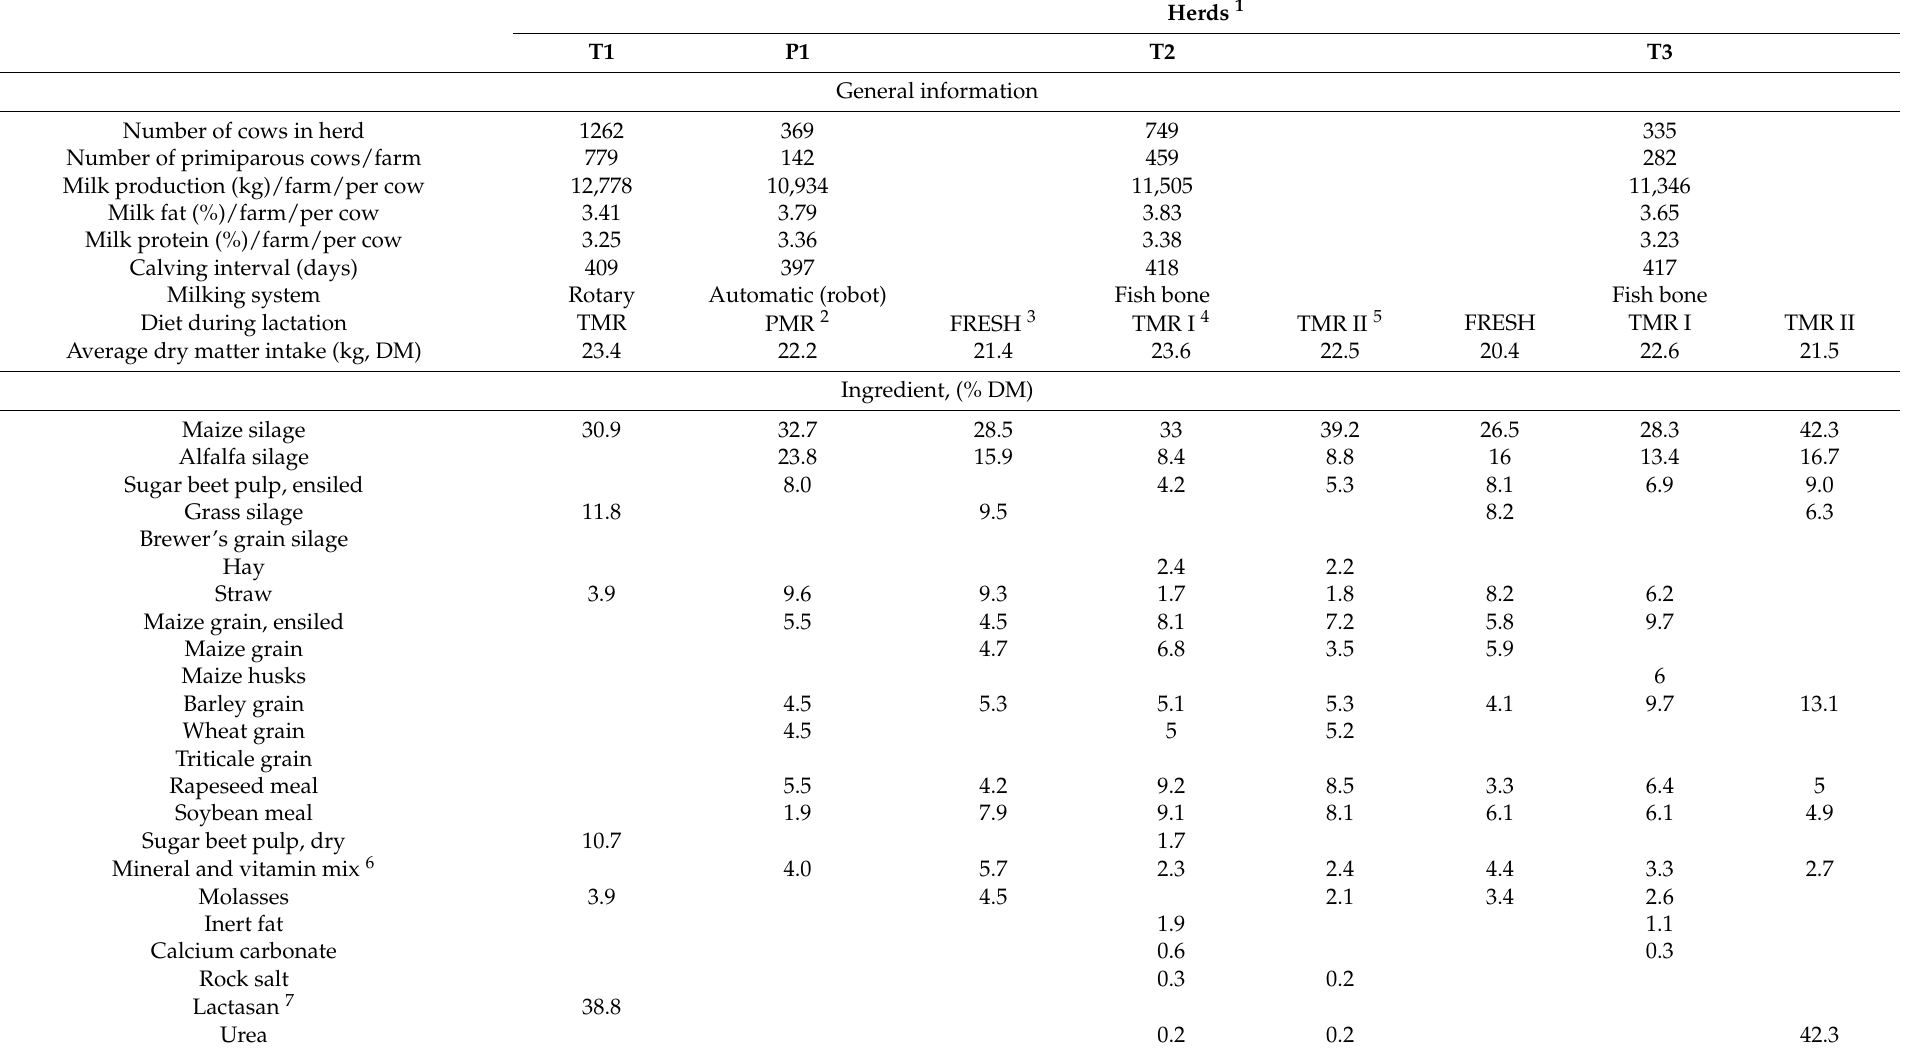
Table 1. General information on the herd and the composition and nutritional value of the